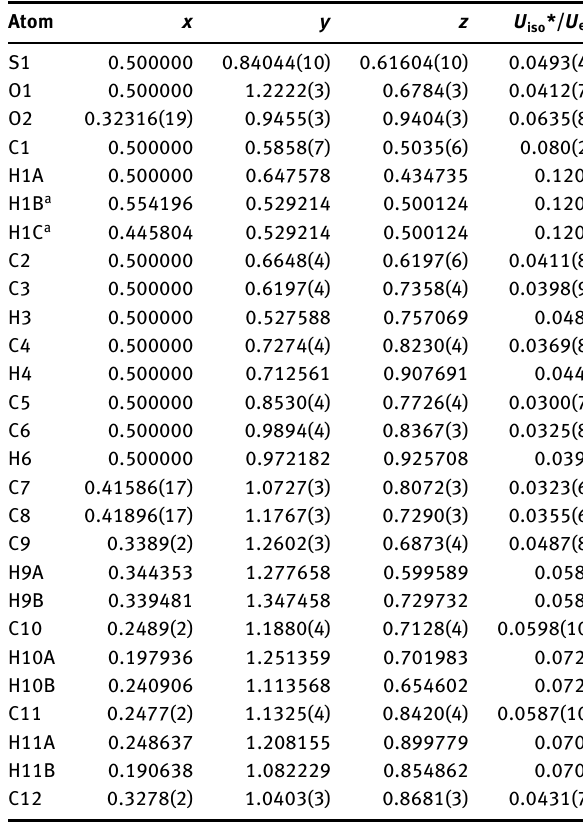
Table 2: Fractional atomic coordinates and isotropic or